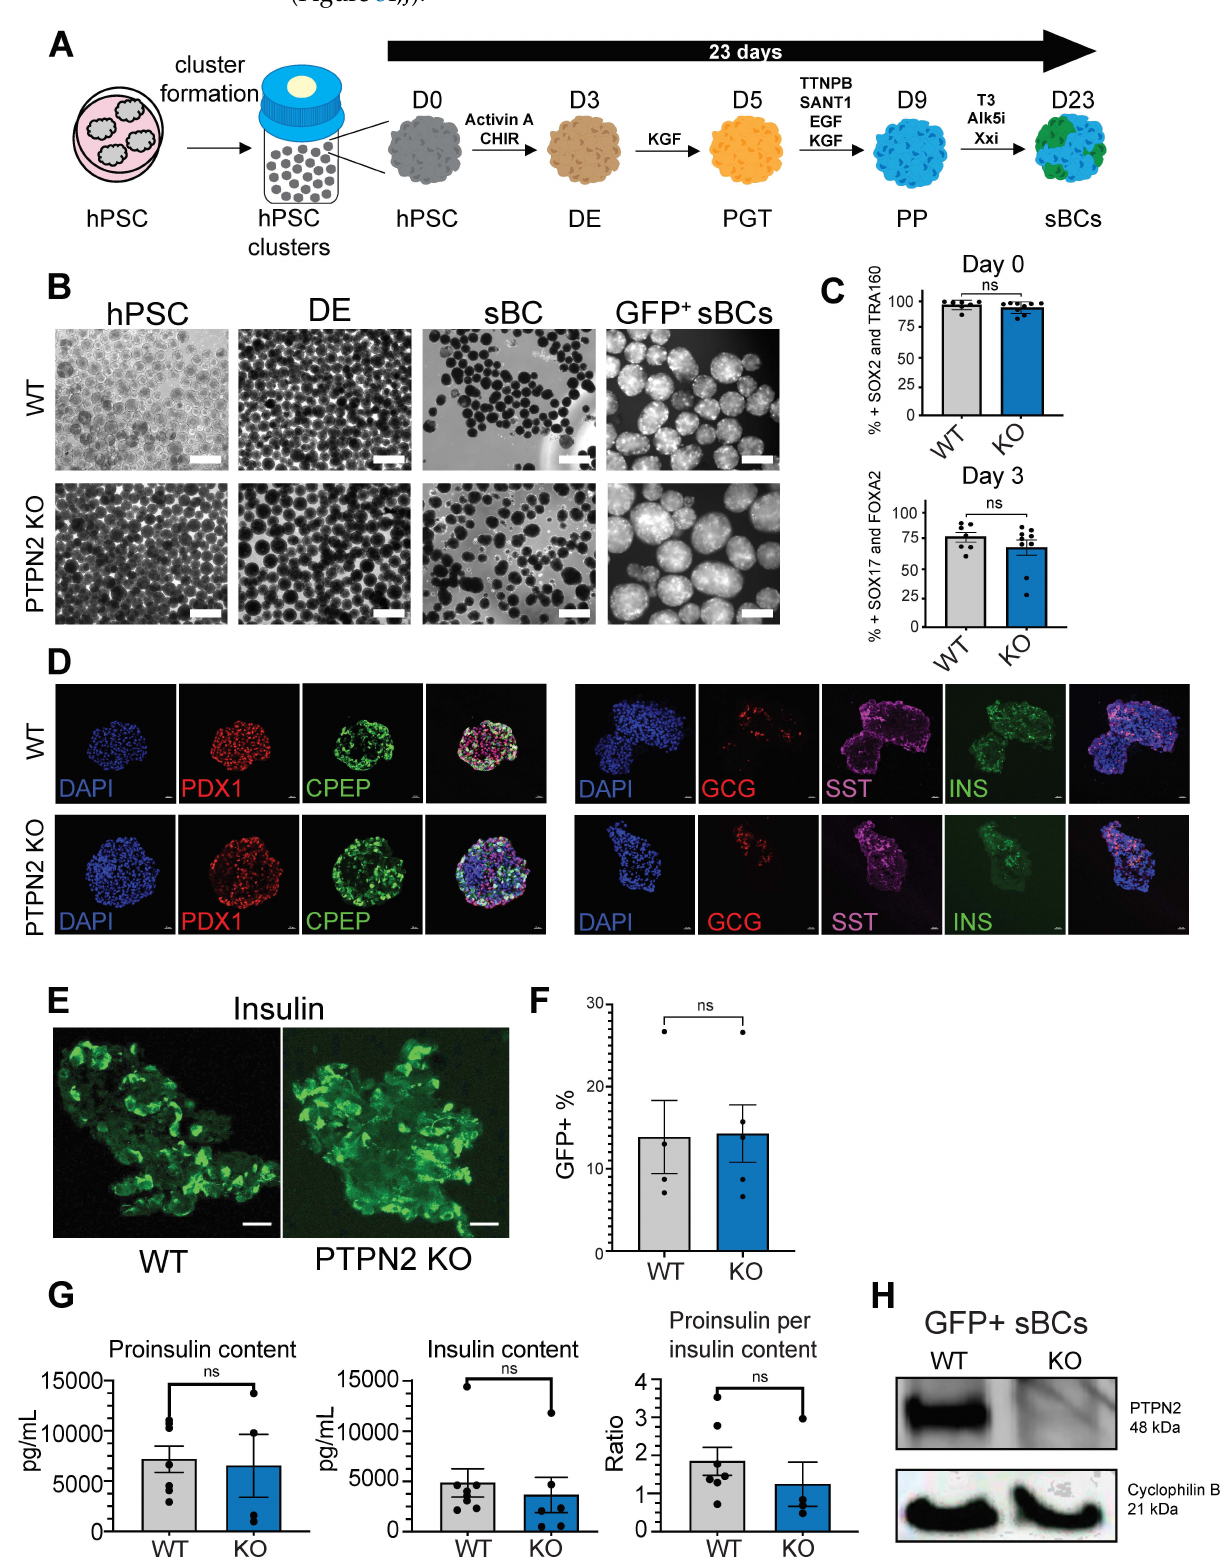
Figure 2. Direct differentiation of WT and PTPN2 KO to generate stem-cell-derived beta-like